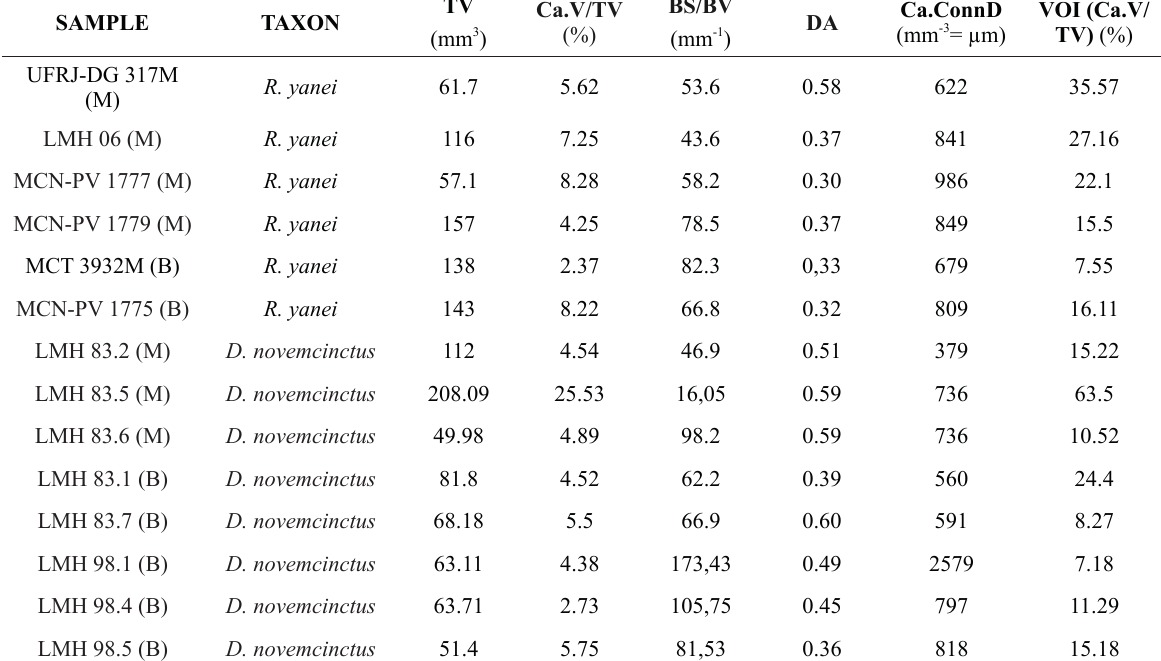
Parameters for quantitative assessment of cortical canal network of Riostegotherium yanei and Dasypus novemcinctus . Specimens LMH 98.1, 98.4 and 98.5 belong to a subfossil specimen of D. novemcinctus from Gruta do Urso, Tocantins state, Brazil. B = buckler; BS/BV = solid surface to volume ratio measured in 3D within the VOI; BV = total volume of binarized objects within the VOI; Ca.ConnD = connectivity density; Ca.V/TV = canal volume to tissue volume ratio (porosity); DA = degree of anisotropy; M = movable; VOI = volume of interest (500 slices or 3.63 mm 3 ); TV = Tissue